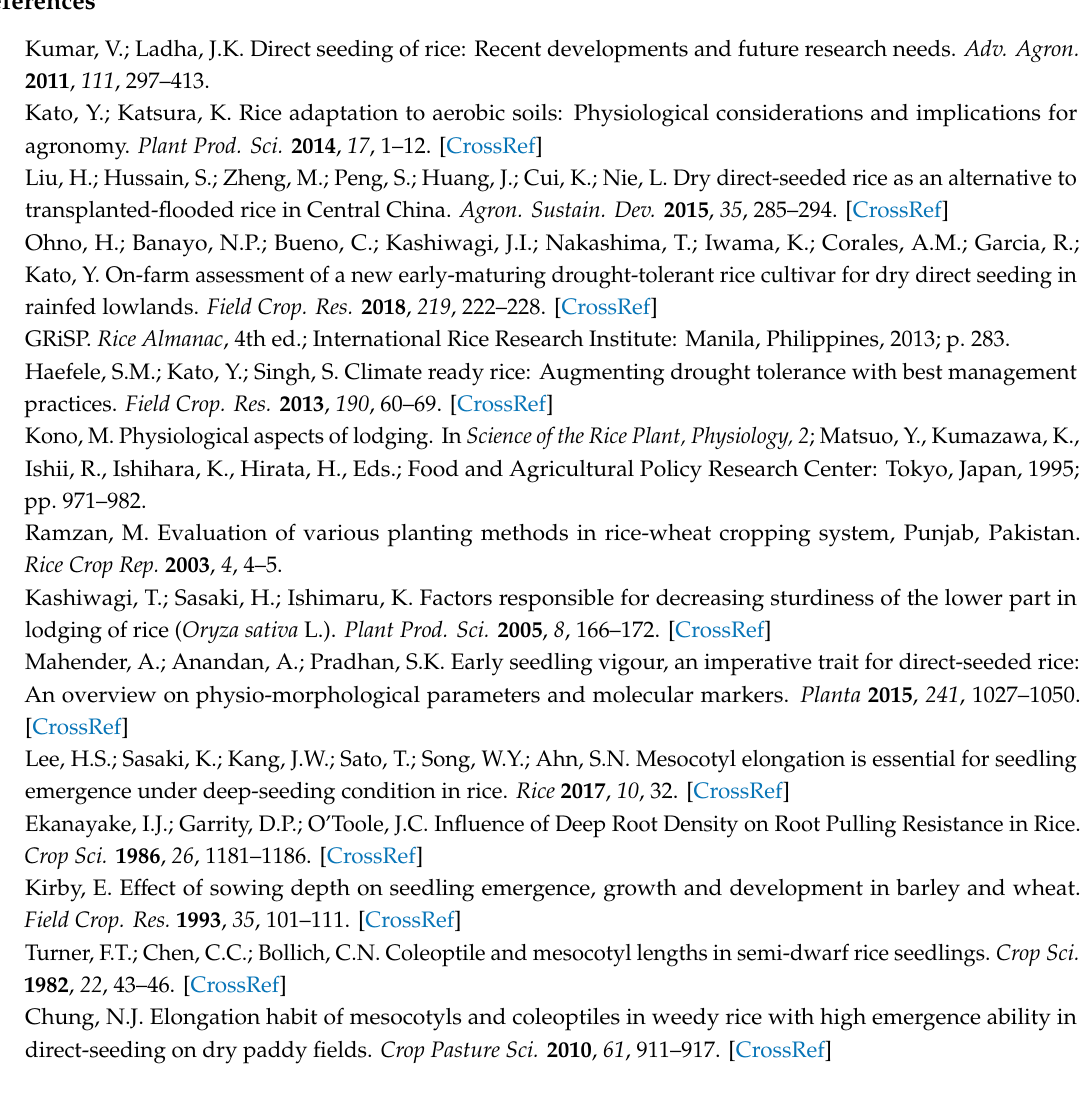
Table S1: Detailed information of 208 rice accessions, Table S2: SNPs significantly associated with mesocotyl length under di ff erent environments, Table S3: Candidate genes for mesocotyl length in 208 rice landraces or varieties, Table S4: Accessions used in qRT-PCR analysis, Table S5: Primers used in this study. The raw Illumina sequencing data will be available upon the